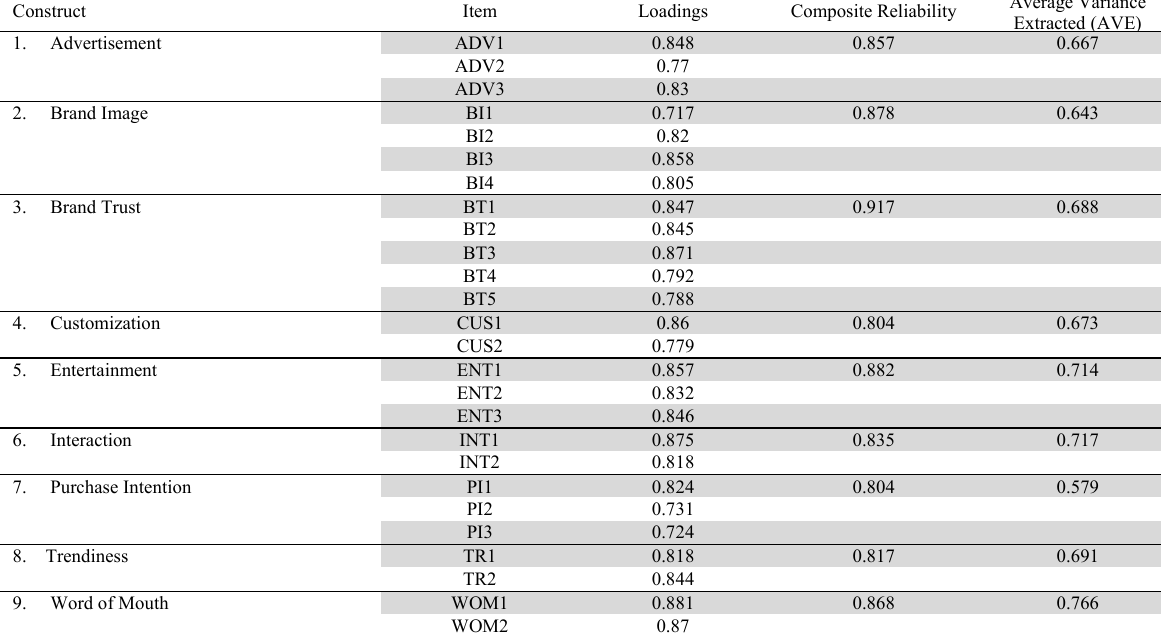
Convergent Validity and Composite Reliability Construct